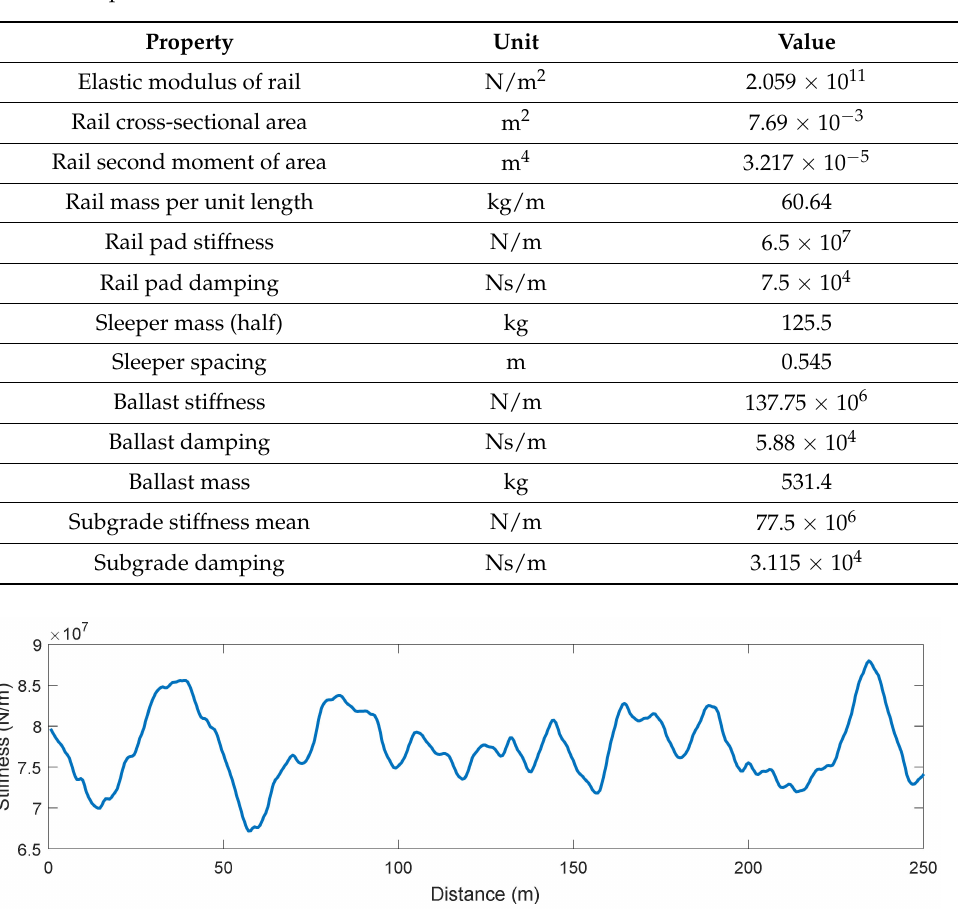
Figure 3. Distribution of subgrade